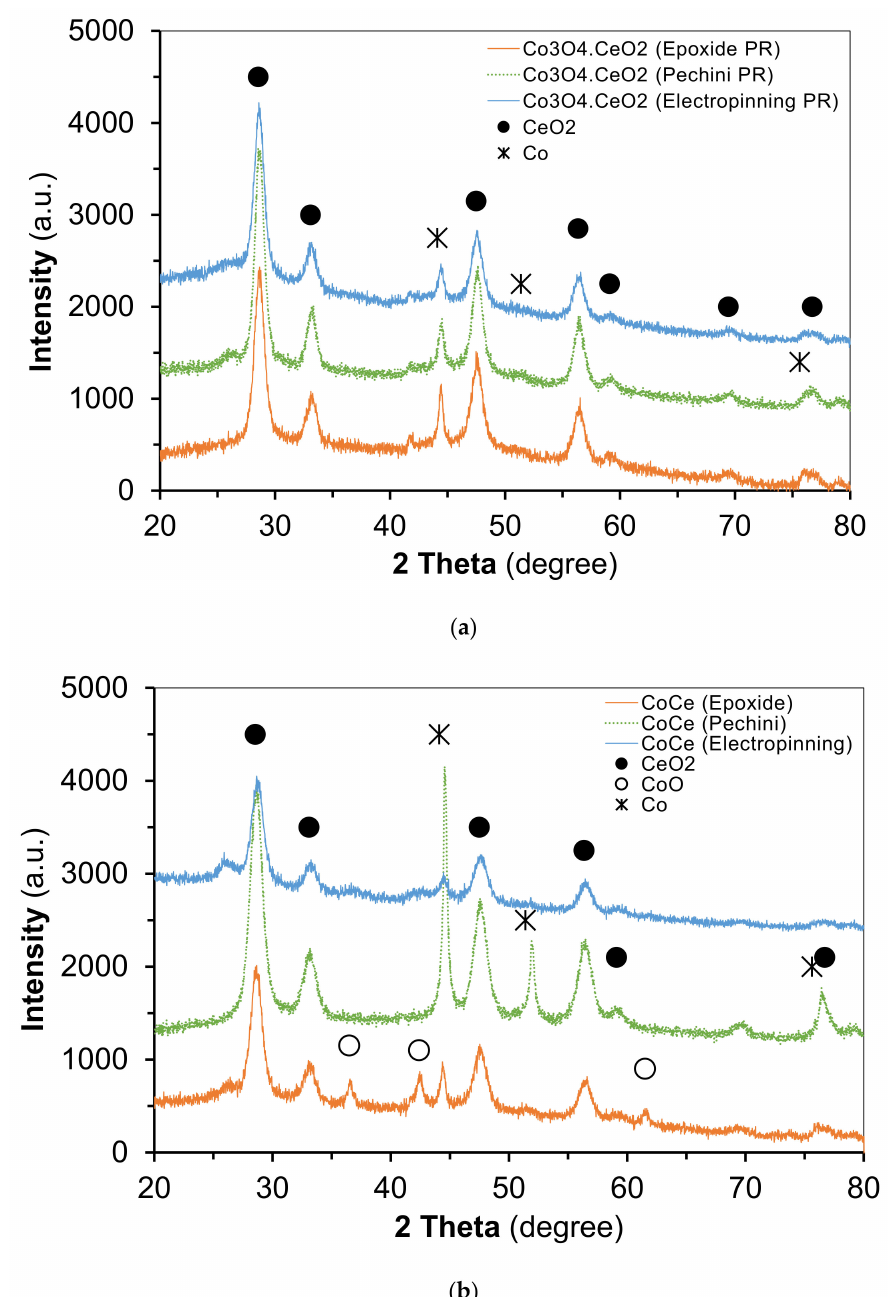
Figure 7. Cobalt–cerium bimetallic oxides prepared by different methods: XRD analysis (powder) after tests under pressure over fresh and reused catalysts, ( a ) and ( b ),